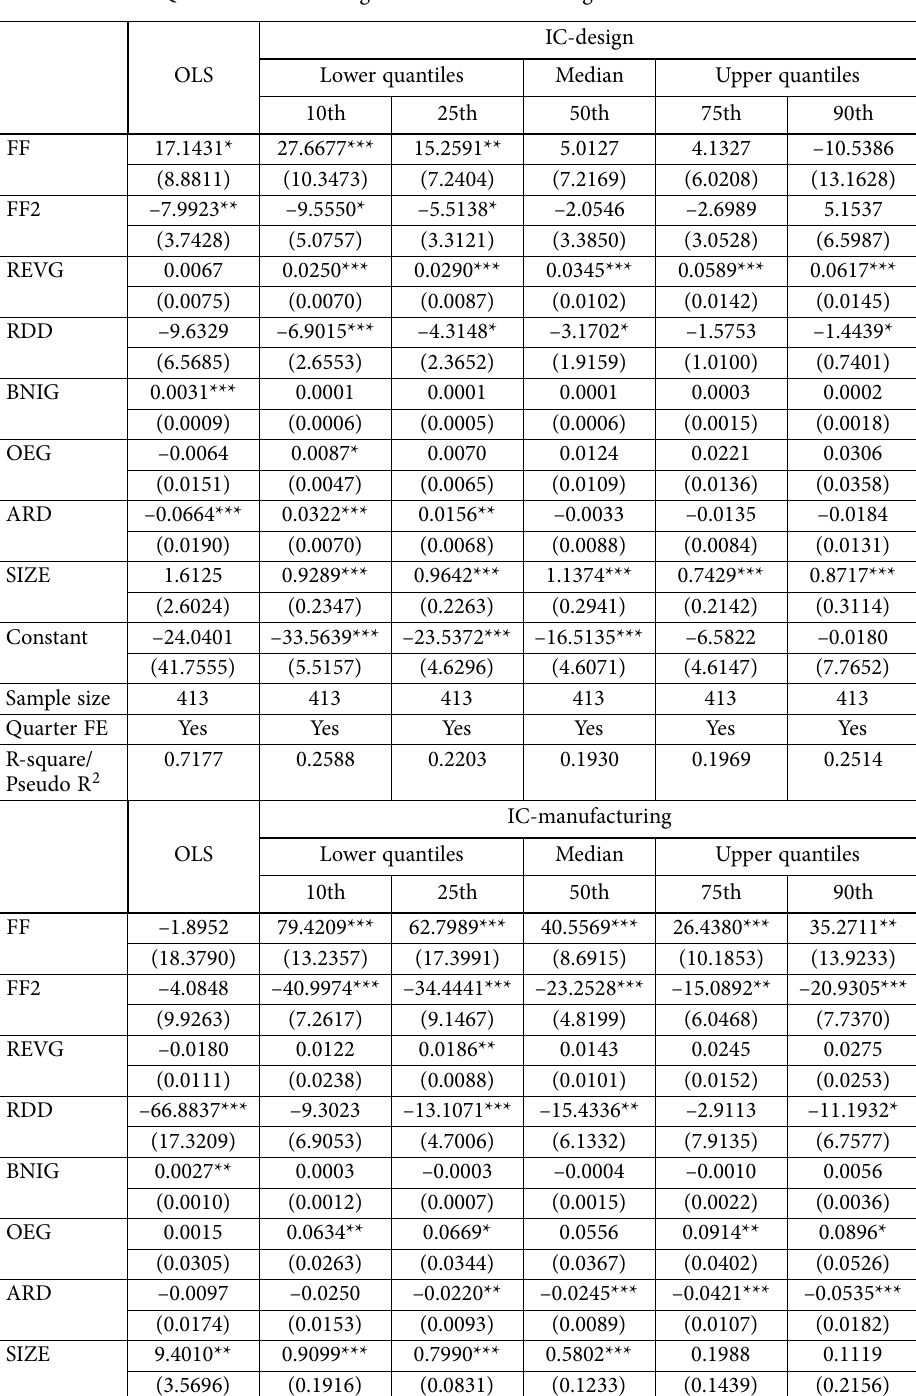
Table 6. OLS and QR results for IC-design and